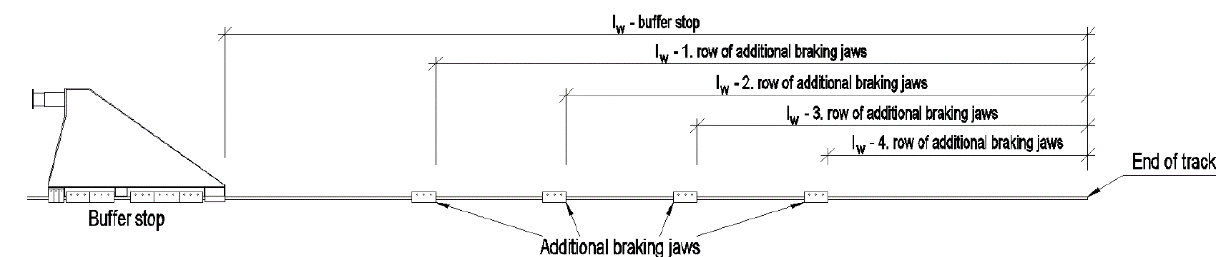
Figure 2. Buffer stop with additional braking jaws.